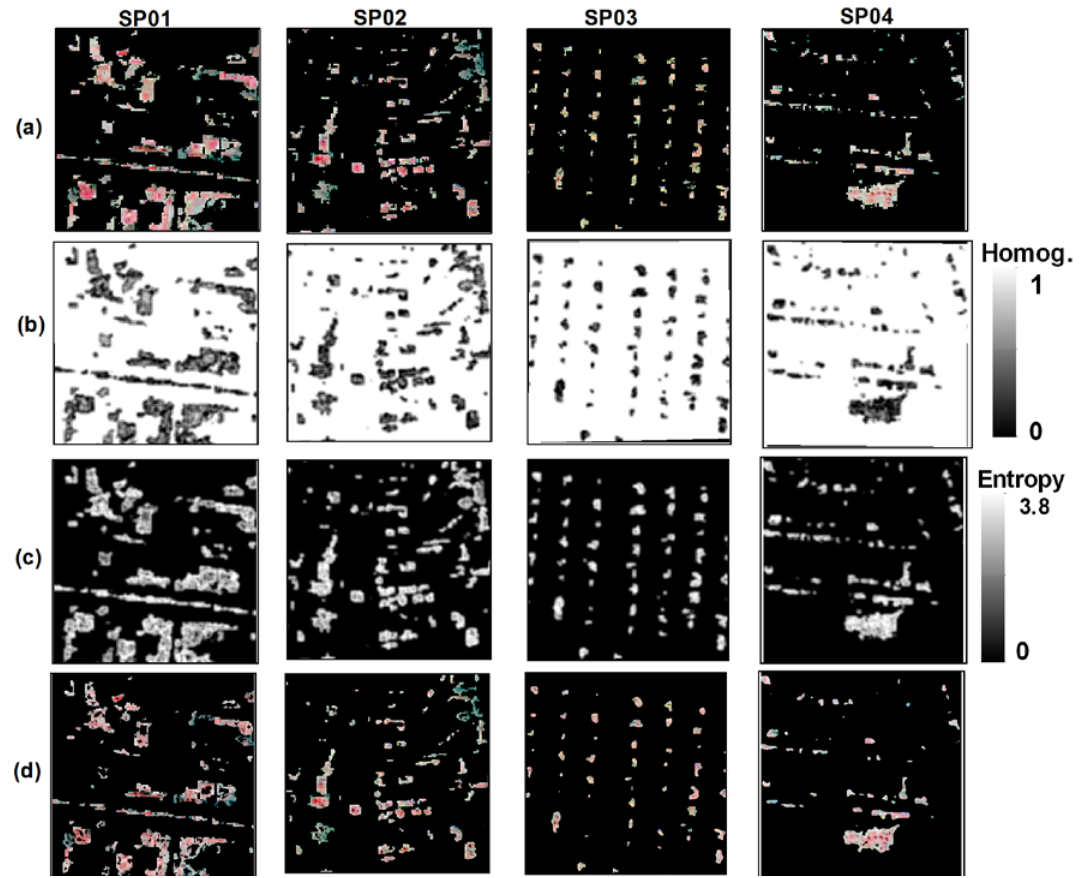
Figure 6: Texture process of four VHR samples. (a) Final output of NDVI process, (b) homogeneity, (c) entropy, (d) Final output of Texture